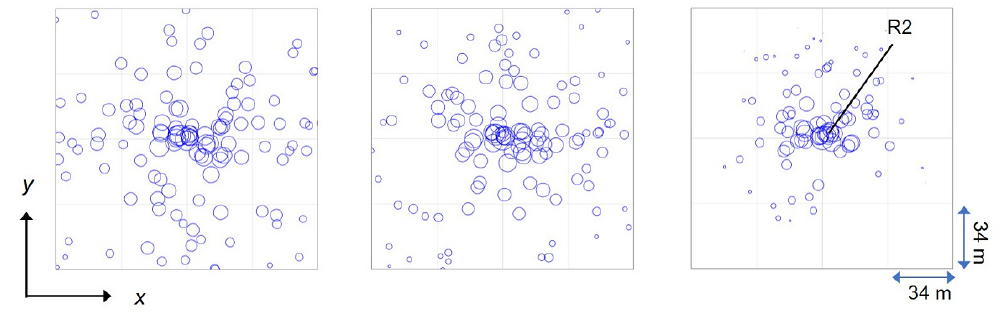
Figure 13. Visualized virtual source locations on the x – y plane for the source to receiver distance of S2 to R2 in the 2 kHz octave band in case 0 ( Left ), case 5 ( Center ) and case 6 ( Right